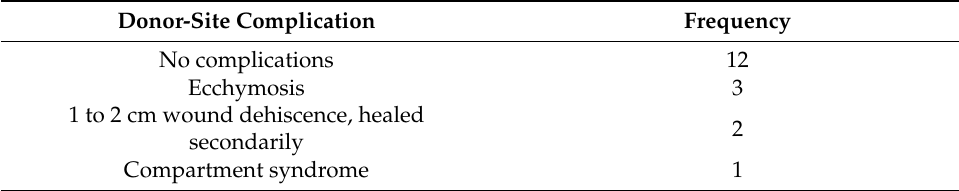
Table 2. Frequency of donor-site complications ( n = 18).